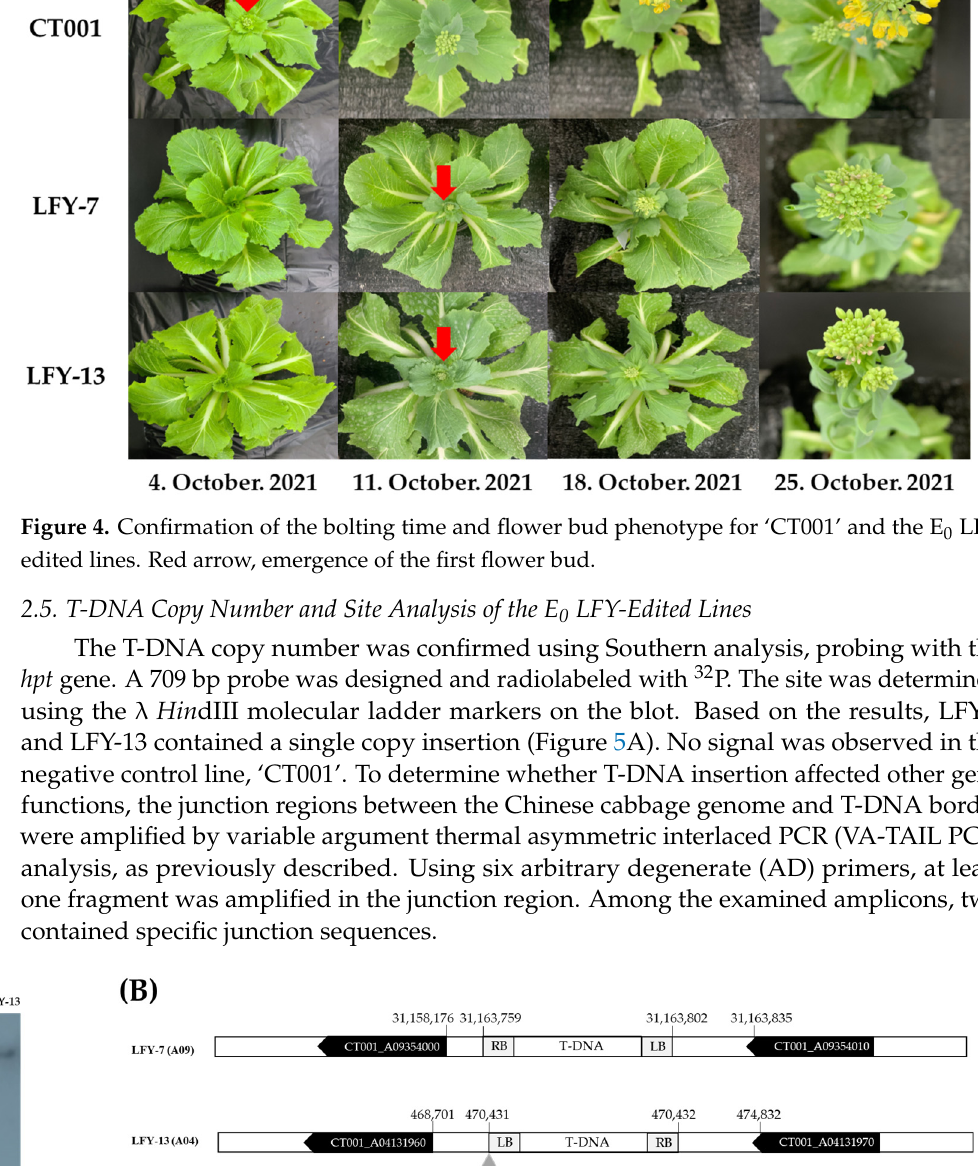
Figure 4. Confirmation of the bolting time and flower bud phenotype for ‘CT001’ and the E 0 LFY- edited lines. Red arrow, emergence of the first flower bud.